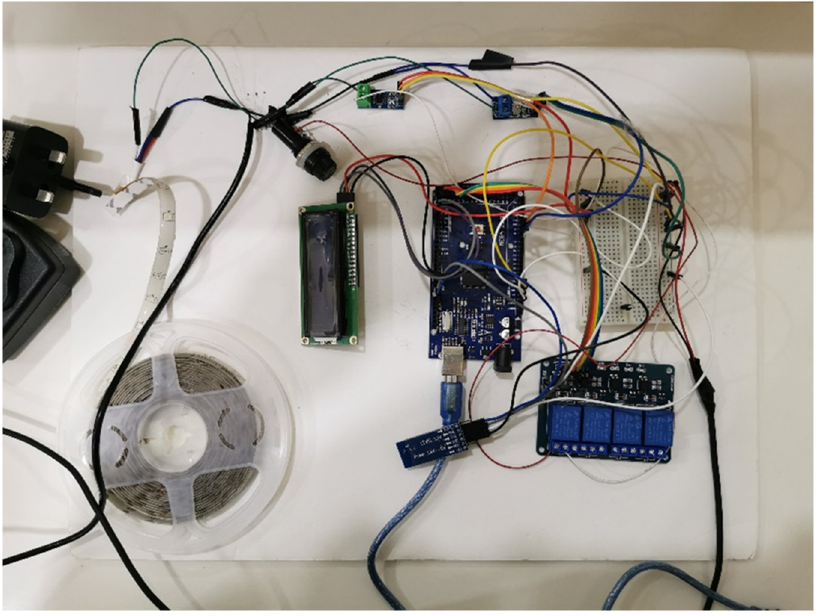
Figure 5. Developed smart distribution board hardware prototype.